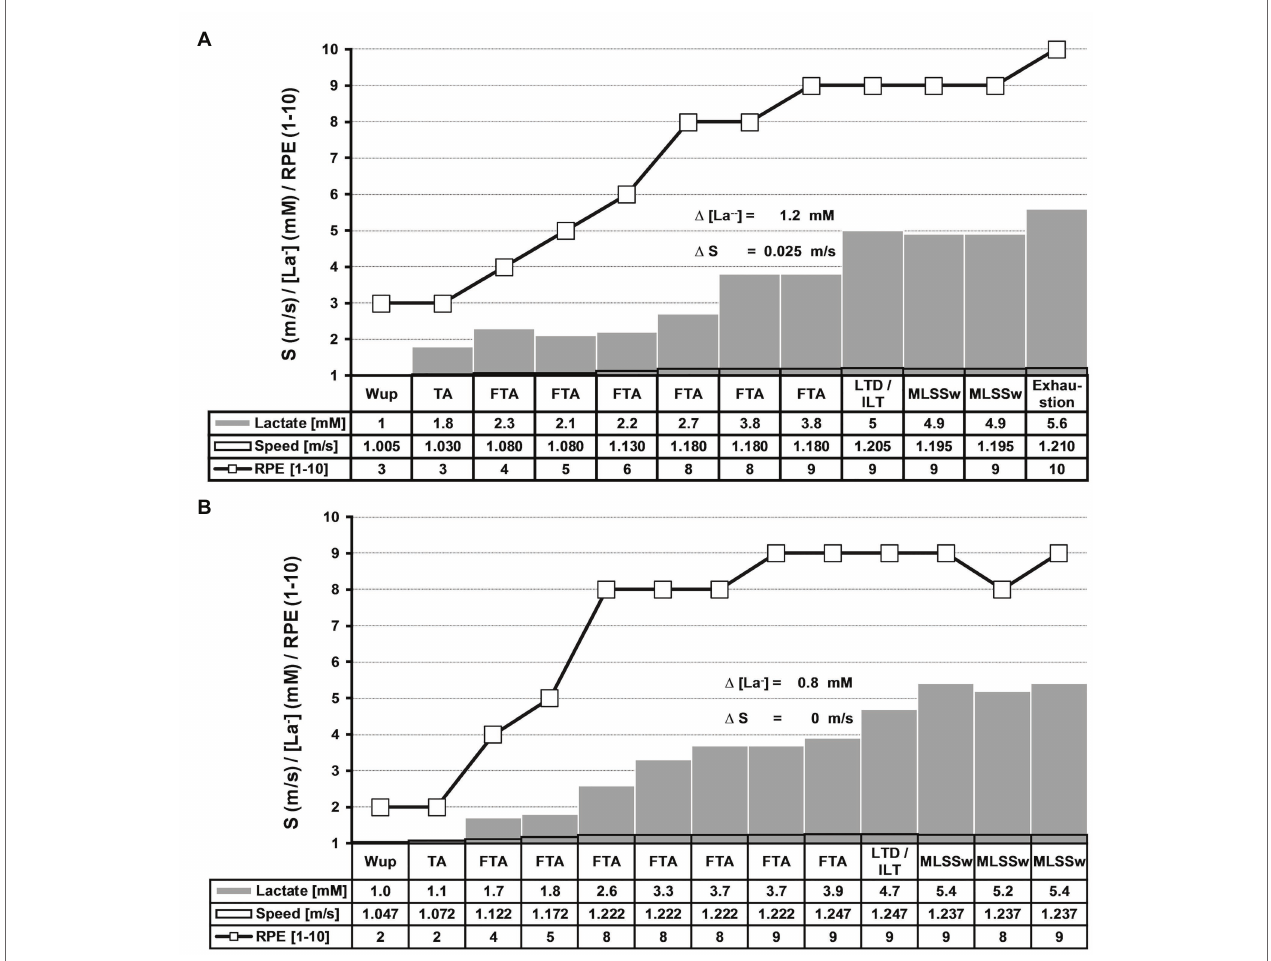
FIGURE 2 | Experimental protocols of two typical ILT-tests. (A) LT detection with threshold criterion 1 (TC1) and (B) with threshold criterion 2 (TC2; Figure 3 ). The basic experimental protocol is identical on the treadmill, bicycle ergometer, and for swimming (for detailed information, see Figures 4A,B ; Hering et al., 2018). After warm-up (W UP ), threshold adjustment (TA), and fine threshold adjustment (FTA; see section “Material and Methods”), a step-like blood lactate accumulation occurred at the individual lactate threshold (ILT; ∆ [La − ]) after 1 (TC1; A ) or after up to six steps (TC2; B ). Immediately or one increment after a comparable slight workload reduction (0.01–0.015 m/s), the lactate accumulation slowed down, indicating the maximal lactate steady state workload (MLSS W ). Real-time workload adjustments were set in accordance to blood lactate level in the previous exercise period, explaining the variable test durations even intraindividually (data not shown). [La − ], blood lactate concentration; RPE, rate of perceived exertion; S,